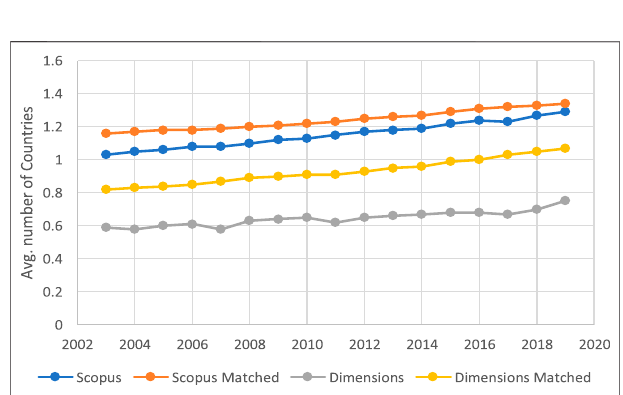
FIGURE 3 | Evolution of the average number of countries per document in Scopus and Dimensions in total and in the matched subsets.